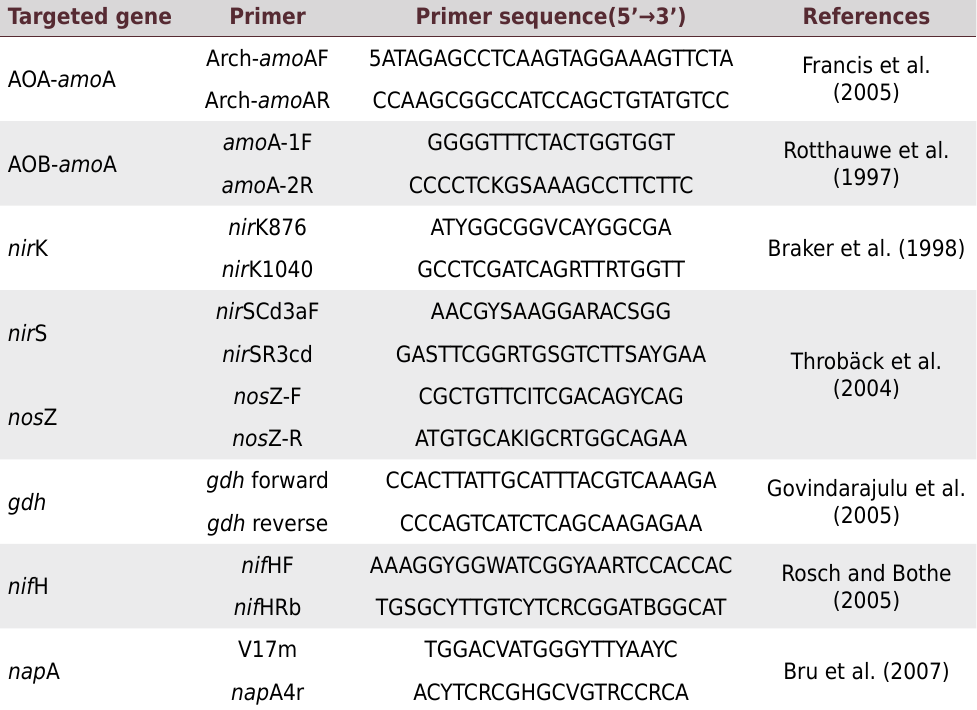
Table 1. Primers of target gens of quantitative PCR Targeted